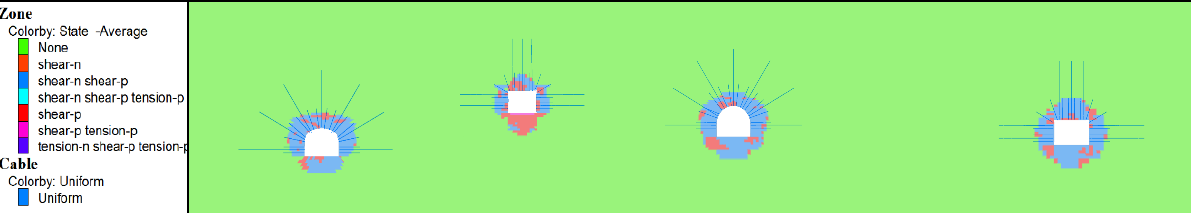
Figure 11. Distribution of plastic zone after roadway group excavation.